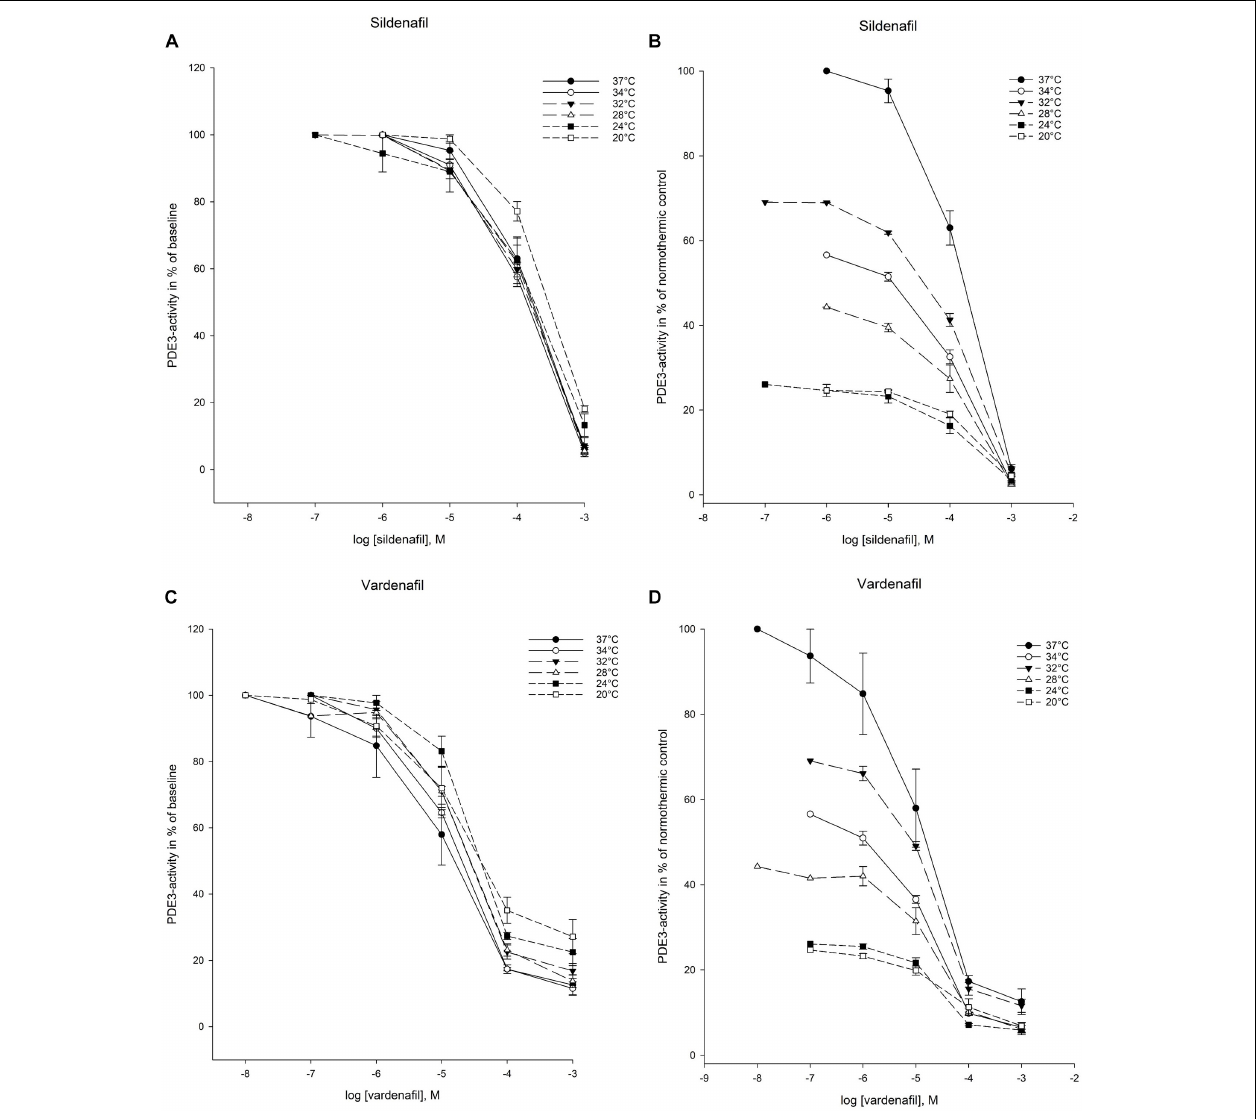
FIGURE 4 | Temperature-dependent inhibition of phosphodiesterase-3 (PDE3) by vardenafil and sildenafil. (A) Sildenafil inhibition curves for PDE3-activity at temperatures ranging from 37 ◦ C to 20 ◦ C. The doses of sildenafil are in logarithm of the concentration in mol/L. (B) Inhibition curves for PDE3-activity by sildenafil in % of normothermic inhibition curve at temperatures ranging from 37 ◦ C to 20 ◦ C. The doses of sildenafil are in logarithm of the concentration in mol/L. (C) Vardenafil inhibition curves for PDE3-activity at temperatures ranging from 37 ◦ C to 20 ◦ C. The doses of vardenafil are in logarithm of the concentration in mol/L. (D) Inhibition curves for PDE3-activity by vardenafil in % of normothermic inhibition curve at temperatures ranging from 37 ◦ C to 20 ◦ C. The doses of vardenafil are in logarithm of the concentration in